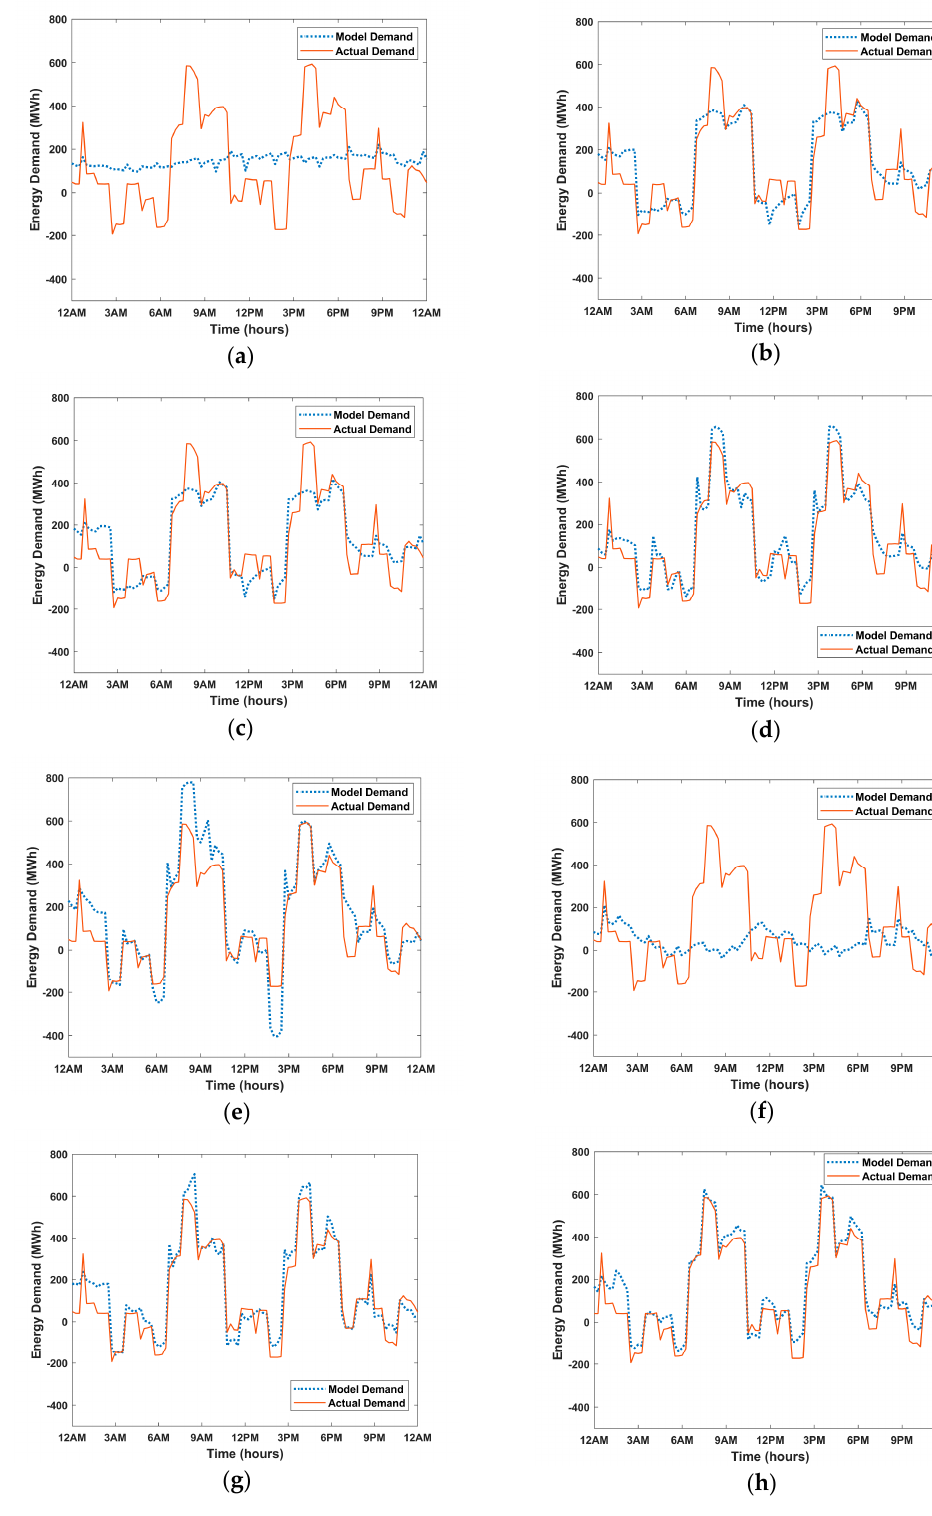
Figure 15. Models validation against actual demand. ( a ) “Base case: no pricing used in inputs” L-ARX regression model; ( b ) One-step L-ARX regression model; ( c ) Two-step L-ARX regression model; ( d ) One-step N-ARX regression model; ( e ) Two-step N-ARX regression model; ( f ) “Base case: No pricing used in inputs” N-ARXnet model; ( g ) One-step N-ARXnet model; ( h ) Two-step N-ARXnet model.